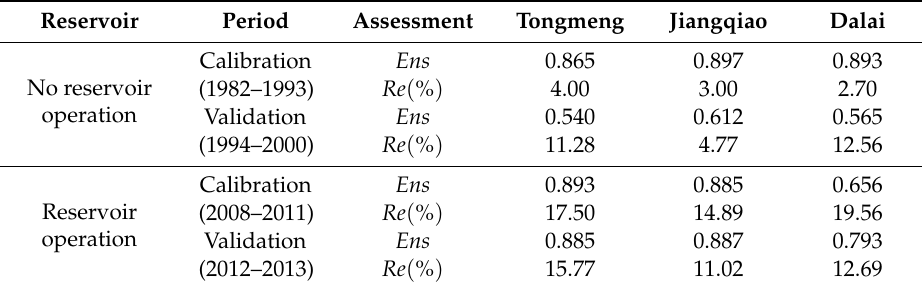
Table 4. Analysis of runo ff simulation results in Nenjiang River